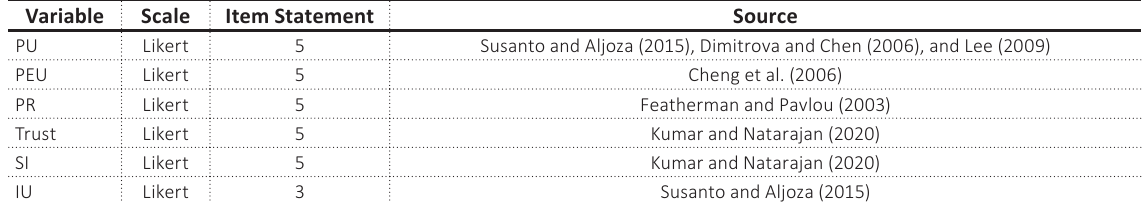
Table 1. Measurement of